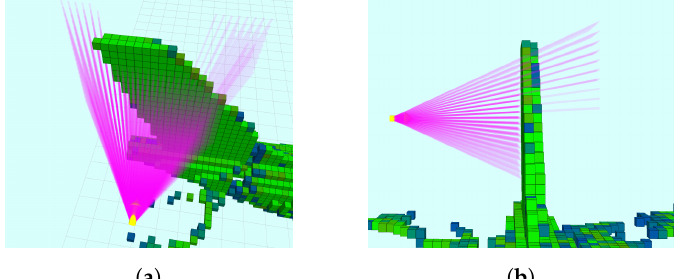
Figure 2. The process of ray tracing. The rays are shown in pink, occupied voxels are green, free voxels are transparent, and unknown voxels are blue. ( a ) Virtual rays are casted from the selected viewpoint (shown in yellow) while respecting the sensor limitations. ( b ) The rays traverse the occupancy map until either the ray reaches the sensor’s maximum range, or the ray is blocked by an occupied